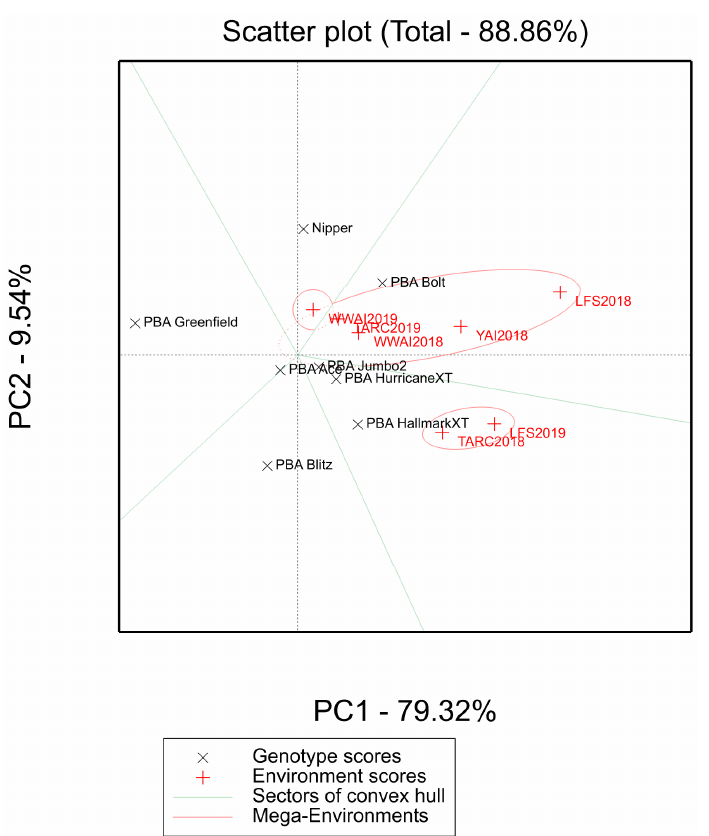
Figure 3. GGE biplot for grain yield showing different vectors and three mega environments and variety performance in the respective vectors and mega environments. The overlapping environ- ments in ME2 are LFS2019 and TARC2018. The overlapping environments in ME3 are WWAI2018 and TARC2019. TARC18 = Trangie Agricultural Research Centre 2018 experiment; TARC19